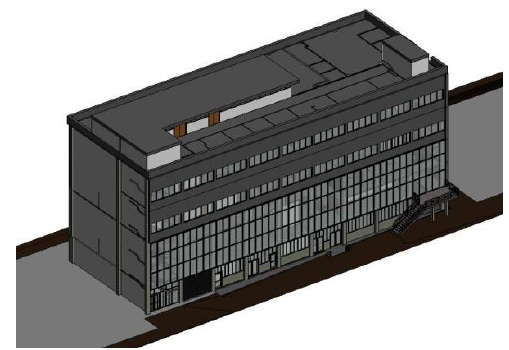
Figure 1. BIM representation of building